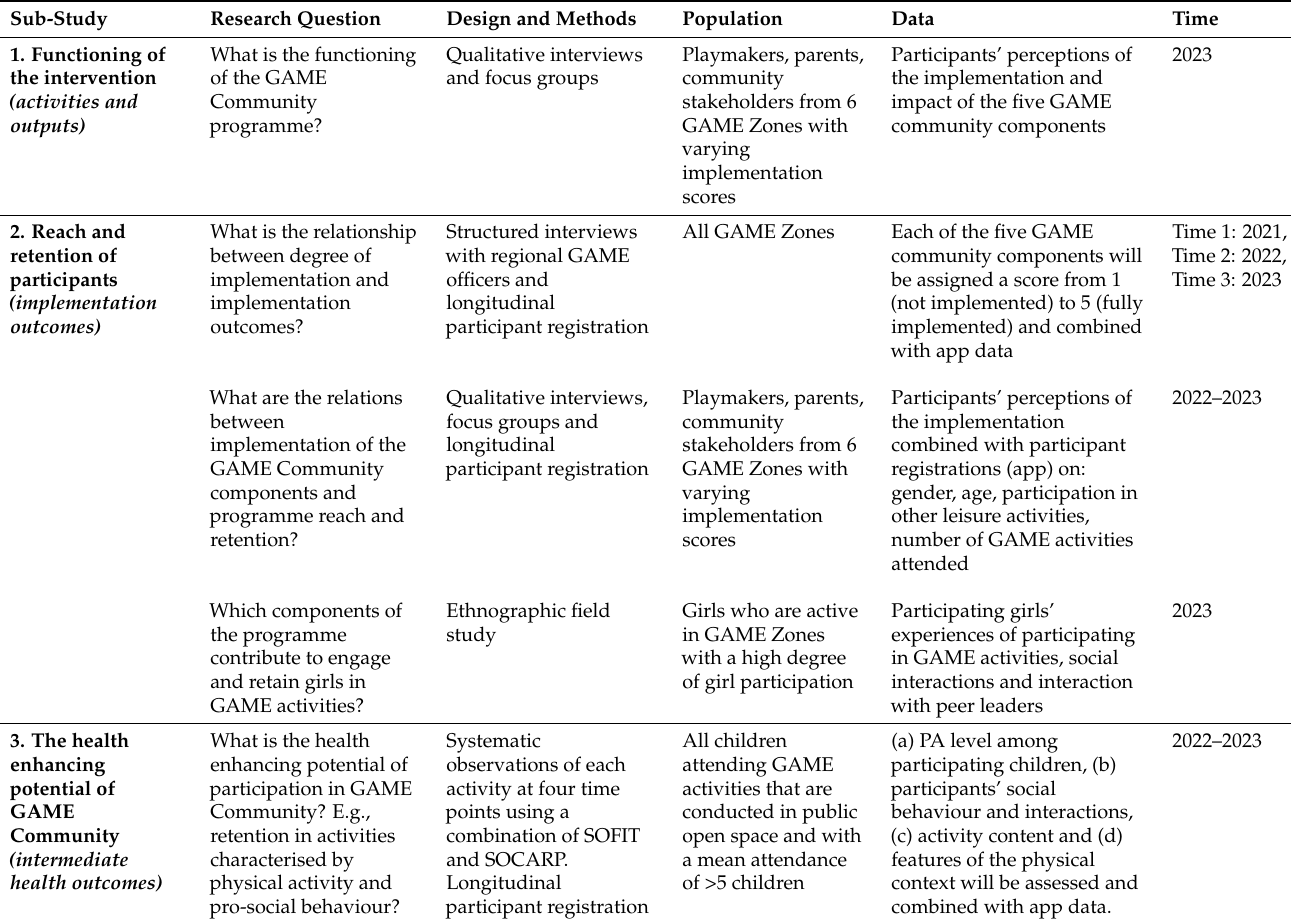
Table 1. Sub-studies in the ASPHALT II